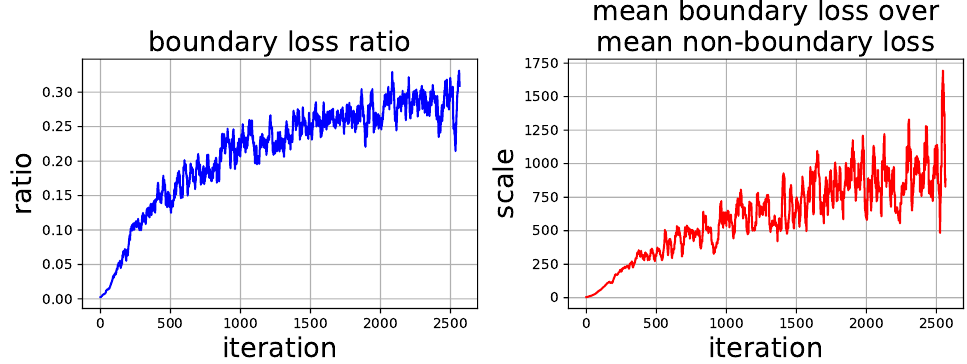
Figure 2. The ratio of loss contributed by boundary pixels and the mean loss value of boundary pixels over non-boundary pixels observed in the training of U-Net on KolektorSDD2 with cross-entropy loss. On average, boundary pixels are 0.008% of all pixels.